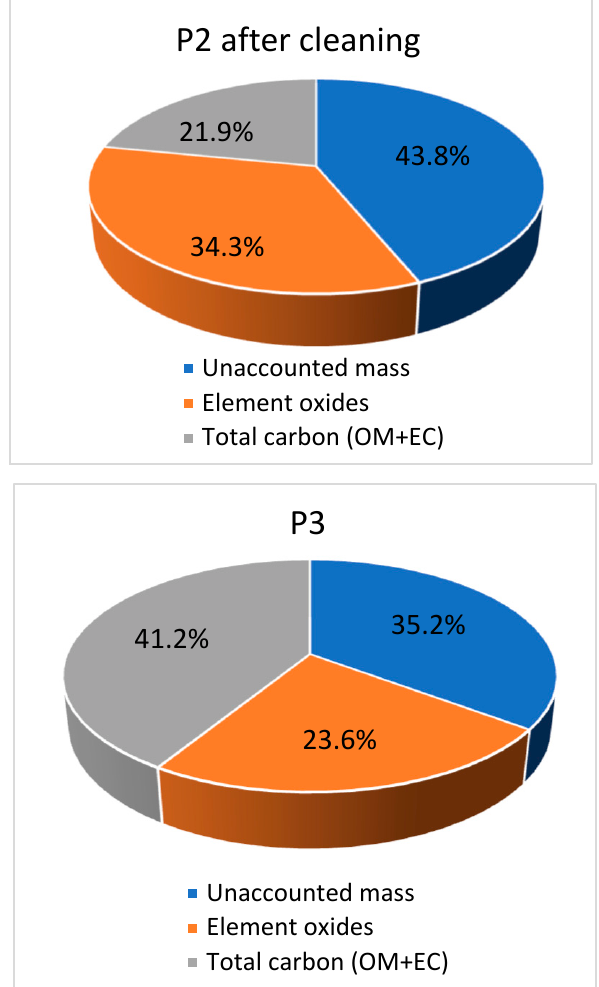
Figure 1. Mass reconstruction with main component groups.